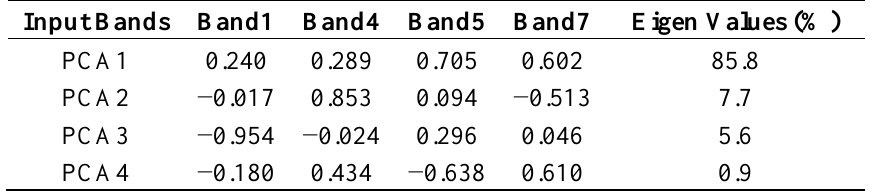
Table 3. The Eigenvector matrix values of PCA for the 1, 4, 5, and 7